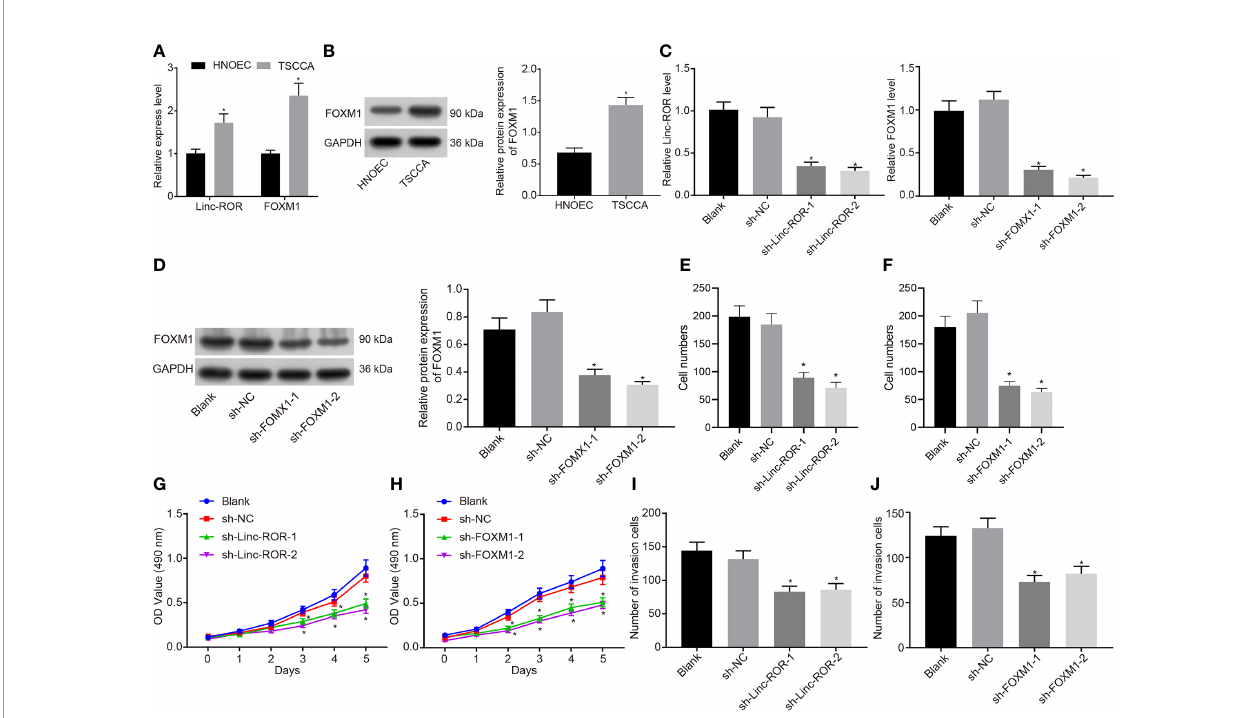
FIGURE 2 | Linc-ROR and FOXM1 are highly expressed in HNSCC cells and promote cell proliferation and invasion. (A) The expression of Linc-ROR and FOXM1 in HNOEC/HL-047 and TSCCA cells detected by RT-qPCR; (B) The protein expression of FOXM1 in HNOEC/HL-047 and TSCCA cells detected by Western blot; (C) The knockdown effects of Linc-ROR and FOXM1 detected by RT-qPCR; (D) The knockdown effects of FOXM1 detected by Western blot; (E) Proliferation ability of TSCCA cells after silencing Linc-ROR detected by monoclonal formation assay; (F) Proliferation ability of TSCCA cells after silencing FOXM1 by monoclonal formation assay; (G) Proliferation ability of TSCCA cells after silencing Linc-ROR detected by MTT assay; (H) Proliferation ability of TSCCA cells after silencing FOXM1 detected by MTT assay; (I) Invasion capacity of TSCCA cells after silencing Linc-ROR detected by Transwell assay; (J) Invasion capacity of TSCCA cells after silencing FOXM1 detected by Transwell assay. In panel (A, B) , * p < 0.05, compared with the HNOEC/HL-047 cells, in panel (C – J) , TSCCA cells transfected with sh- NC. All experiments were repeated three